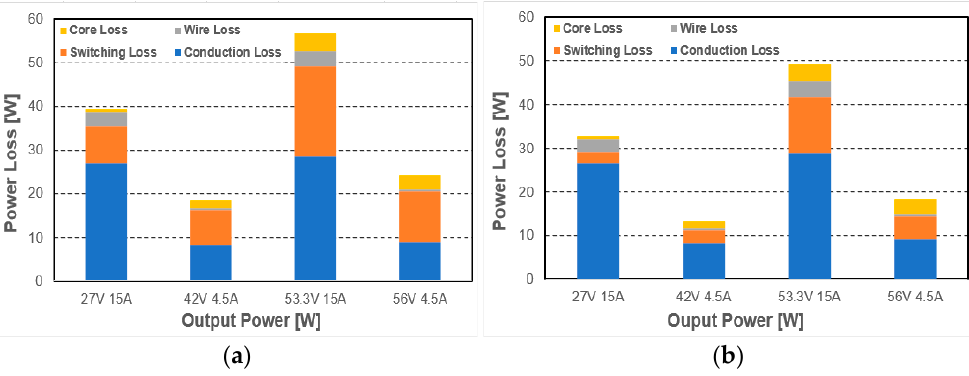
Figure 9. Simulation loss analysis: ( a ) conventional active ‐ clamp forward converter; ( b ) proposed active ‐ clamp forward converter.